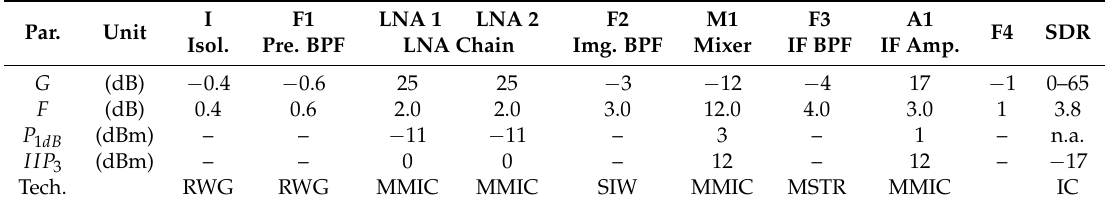
Table 4. Specification Breakdown of the Receiver Building